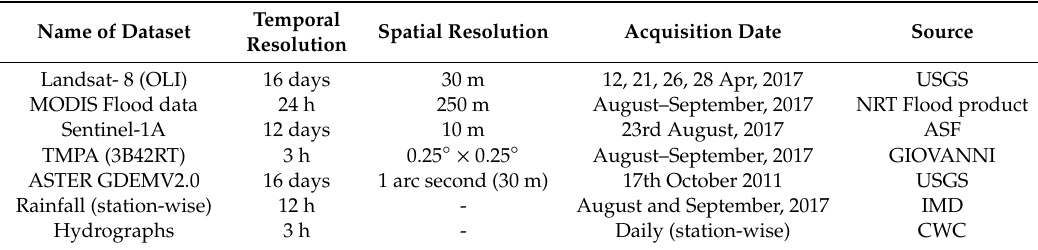
Table 1. Characteristics of the satellite and secondary data used in this study. The satellite data were acquired in the month of August and September, 2017. The abbreviations used are: USGS (United States Geological Survey), NRT (Near Real Time), ASF (Alaska Satellite Facility), IMD (Indian Meteorological Department), CWC (Central Water Commission) and GIOVANNI (Geospatial Interactive Online Visualization ANd aNalysis